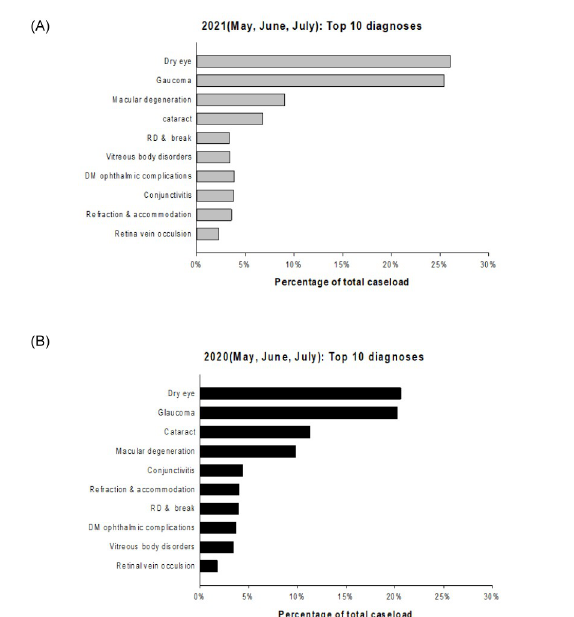
Fig 3. Comparison of most common diagnoses of ophthalmic outpatients during (A) the COVID-19 pandemic period and (B) the same period in 2020. RD, retinal detachment; DM, diabetes mellitus.